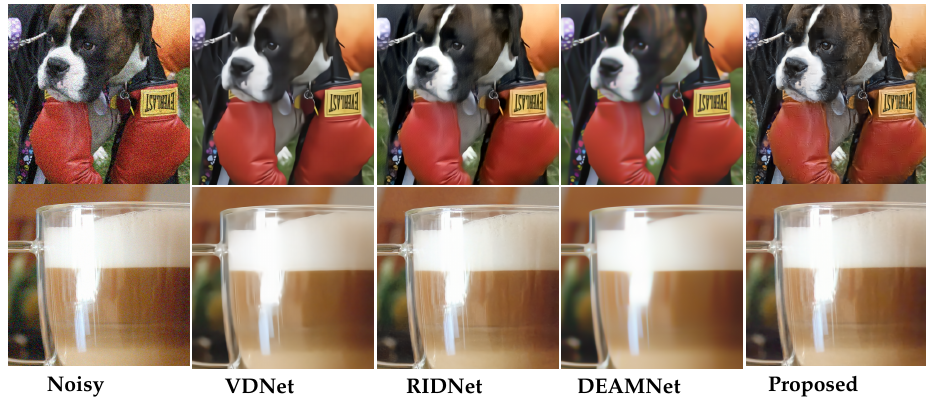
Figure 13. Visual quality comparison for “Dog" and “Glass” from the RN15 dataset. RN15 dataset is a set of real noise images without the clean image counterparts (for best view, zooming in is recommended).